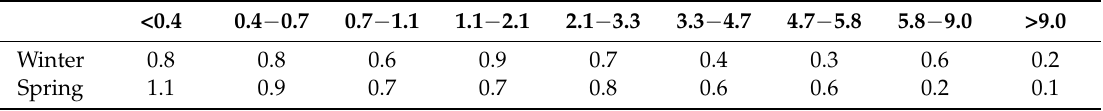
Table 2. Ratios of mass concentrations of indoor/outdoor fractions of SSAs in winter and spring ( n =